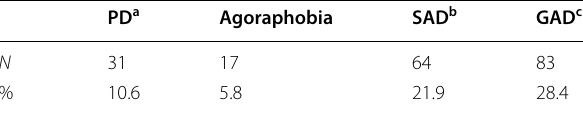
Table 3 Frequency of different anxiety disorders in patients with substance use disorder